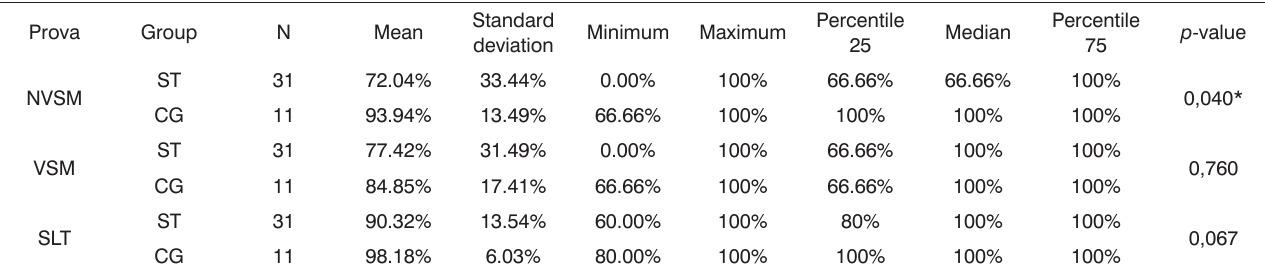
Table 2. Distribution of the correct answers percentage mean value in the Simplified Auditory Processing Assessment tests seen in the SG and CG children.